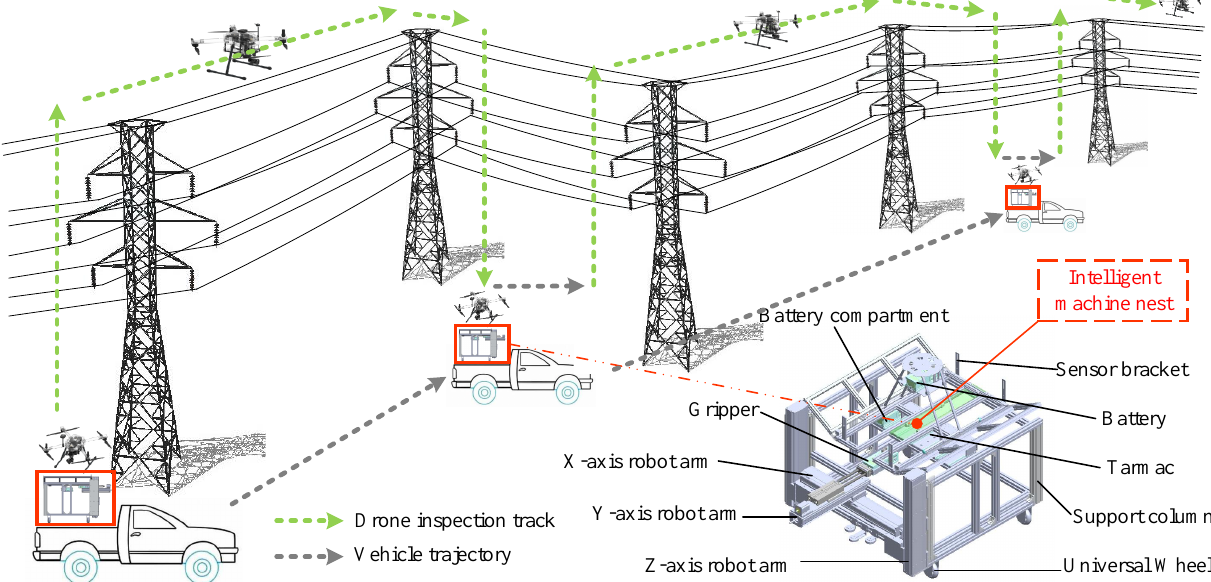
Figure 6. Intelligent machine nest. Green is the drone inspection route and gray is the vehicle route. The whole structure of the intelligent machine nest is shown in the lower right corner of Figure 6. The upper surface is the apron, its structure with beveled edges on the left and right can make up for the accuracy error of the inspection drone landing on the apron, and four sensor brackets are installed on the apron to detect whether there is an inspection drone on the apron. Four cylinders are installed on the lower surface of the apron, which